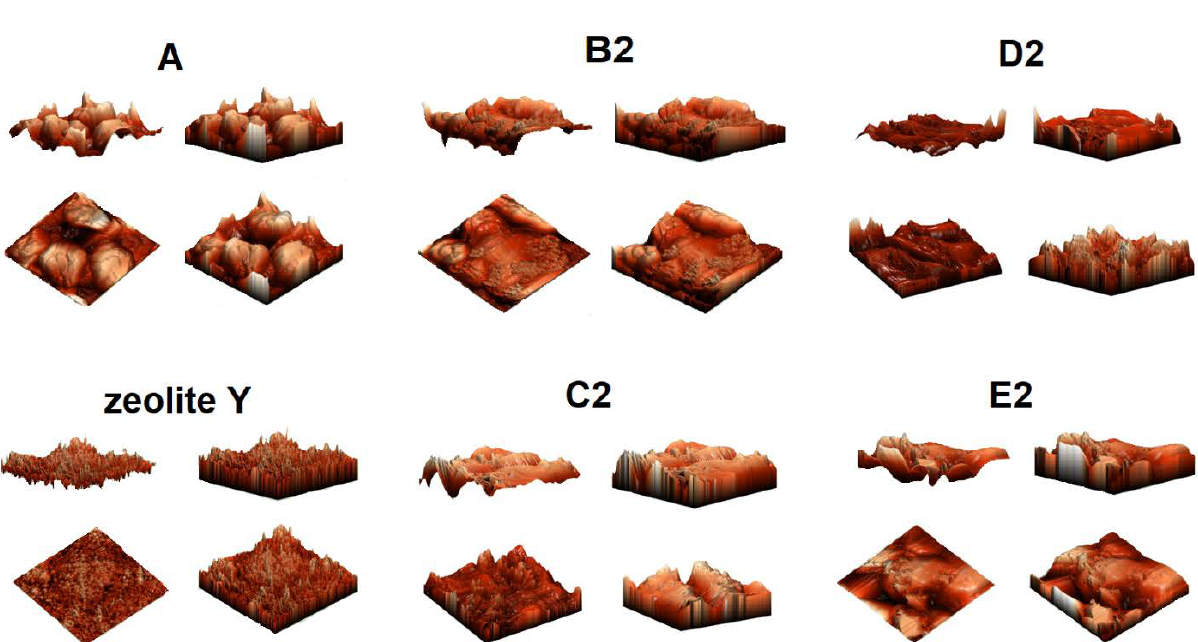
Figure 4. AFM visualization of the surface of ANFO samples in different projections.